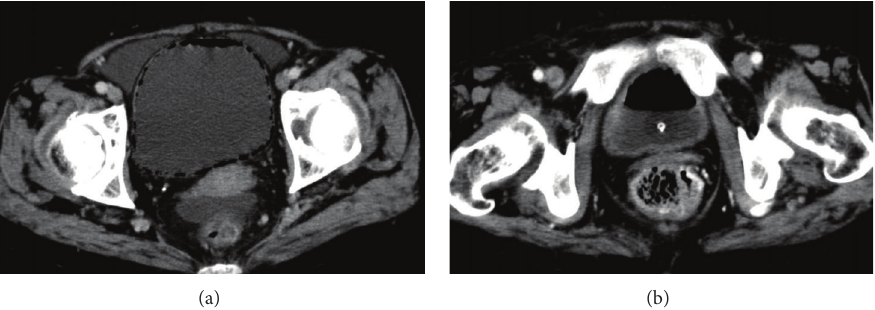
Figure 1: CT findings of the pelvis. (a) CT showed diffuse air within the bladder wall. (b) CT after treatment showed disappearance of air within the bladder wall and normally observed air in the bladder lumen during placement of Foley catheter.